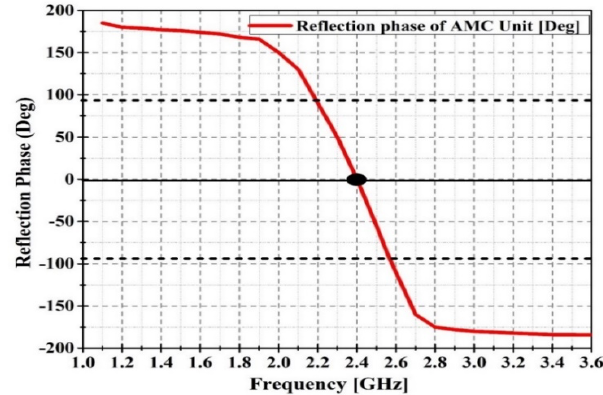
FIGURE 3. Reflection phase of the AMC unit cell.